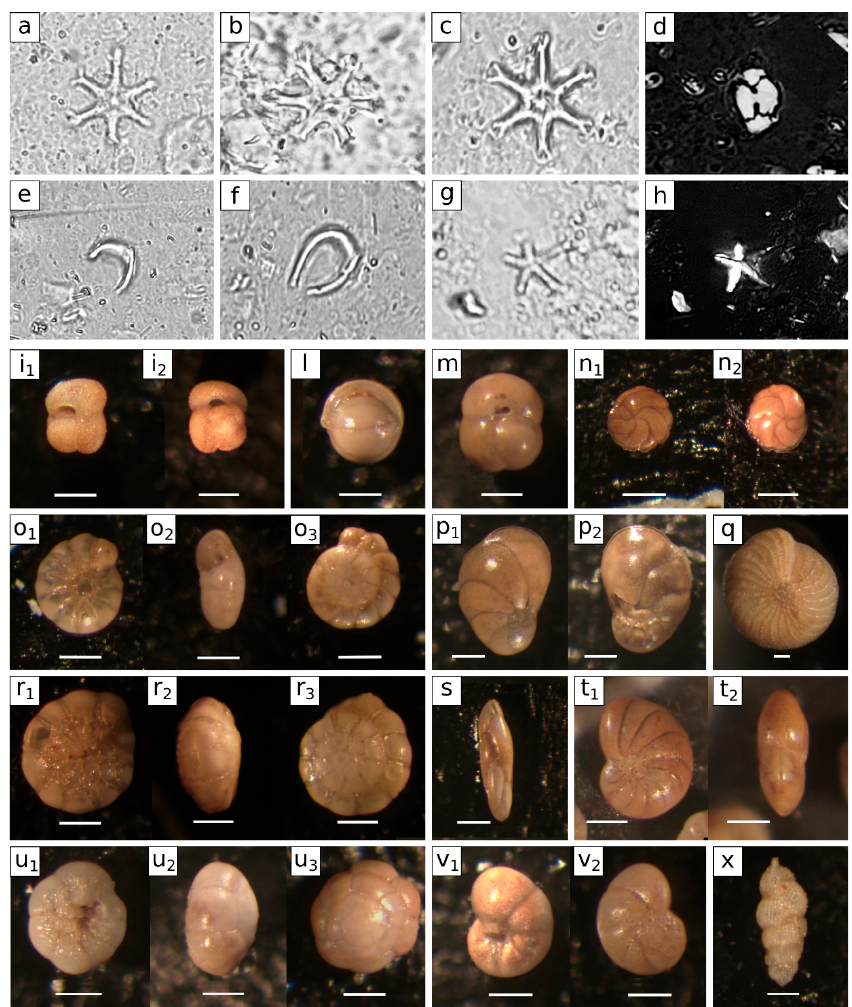
Figure 11. Microphoto of calcareous nannofossil ( a – h ; optical microscope 1000 × magnification) and Foraminifera ( i – x ; scale bar 200 µ m). ( a ) Discoaster surculus (// nicols, PM68); ( b ). Discoaster subsurculus (// nicols, PM68); ( c ) Discoaster variabilis (// nicols, PM28); ( d ) Helicosphaera sellii (X nicols, PM63); ( e ) Amaurolithus primus (// nicols, PM66); ( f ) Amaurolithus delicatus (// nicols, sample PM68); ( g ) Discoaster pentaradiatus (// nicols, PM67); ( h ) Discoaster pentaradiatus (X nicols; PM67). ( i ) Globigerinoides cf. elongatus (PM 64, 1—umbilical and 2—spiral view); ( l ) Pullenia bulloides (PM 52, apertural view); ( m ) Sphaeroidina bulloides (PM 52, umbilical view); ( n ) Cassidulina neocarinata (PM60, 1-apertural/side view and 2-side view); ( o , r ) Ammonia beccarii (PM 75, 1—umbilical, 2—apertural and 3—spiral view); ( p ) Cancris auriculus (PM59, 1—spiral and 2—umbilical view); ( q ) Elphidium crispum (PM76, side view); ( s ) Fursenkoina schraebersiana (PM59, side view); ( t ) Nonion boueanum (PM 03, 1-side and 2-apertural view); ( u ) Ammonia inflata (PM59, 1—umbilical, 2—peripheral and 3—spiral view; ( v ) Valvulineria bradyana (PM59, 1—umbilical and 2—spiral view); ( x ) Uvigerina pygmaea (PM59, side